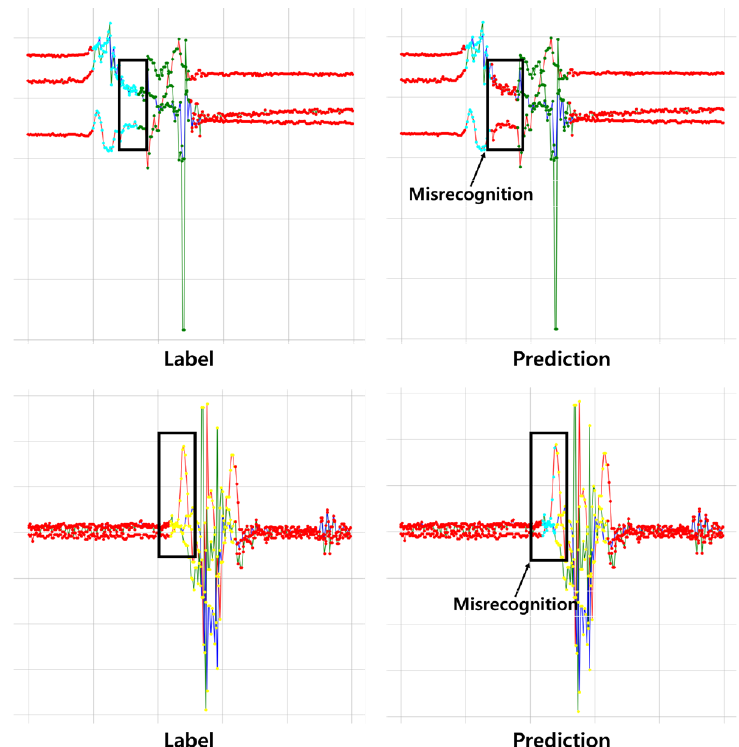
Figure 7. Example of misrecognition of SW method.